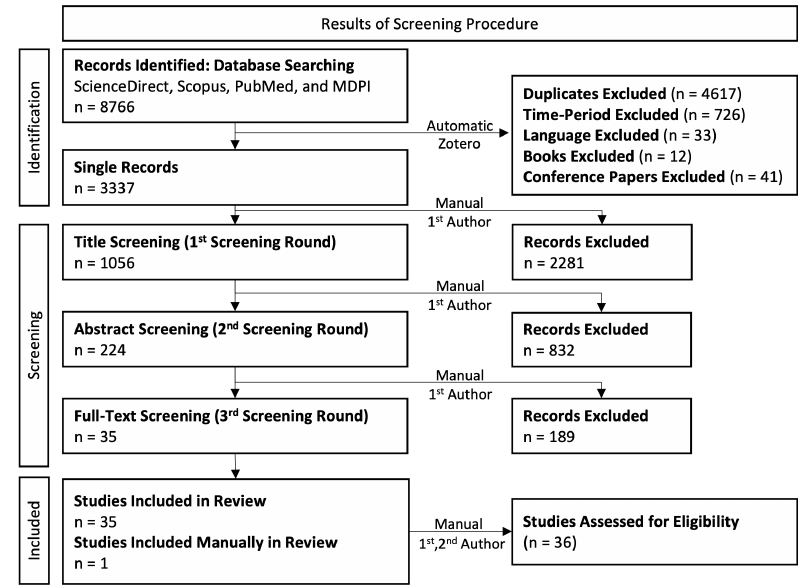
Figure 1. Flow chart of the screening procedure.